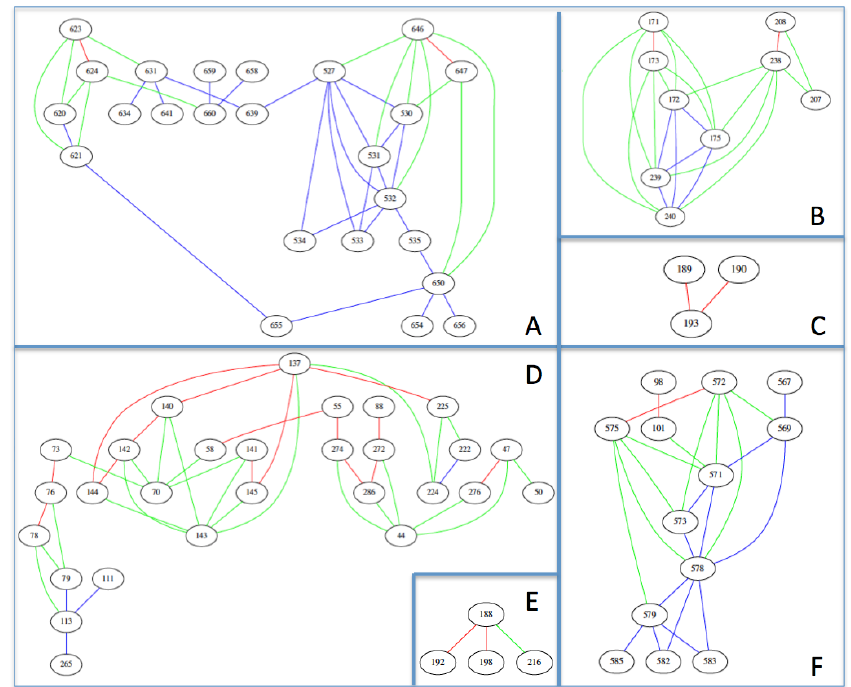
Figure 3. Graph representation of interactions between spatially close SL and invariant positions on the surface of influenza A H1N1 HA. Nodes are positions of HA. Edges between two positions means that these positions are spatially close (less than 10 Å ) and at the surface of HA. Couples of SLs are linked by red edges. Couples with an SL and an invariant position are linked by green edges. Couples of invariant positions are linked by blue edges. Note that while the protein has only 483 positions (323 AA for HA1 and 160 for HA2), the numbering is up to 660 positions. The numbering of the residues is based on the numbering of the PDB structure of 1RU7 where the numbering is as follows, from 5 to 327 (HA1) then from 501 to 660 (HA2). Six sets of interactions are divided into six sub-graphs consisting of 24 ( A ), 9 ( B ) 3 ( C ), 28 ( D ), 4 ( E ) and 13 ( F ) positions.